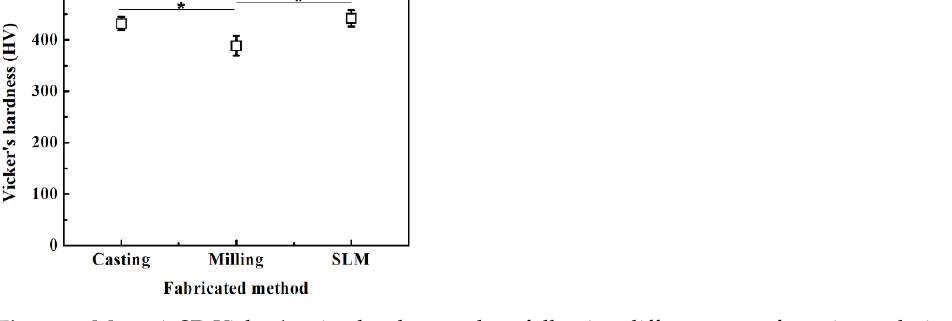
Figure 3. Mean ± SD Vicker’s microhardness values following different manufacturing techniques. *, significant at p < 0.05.